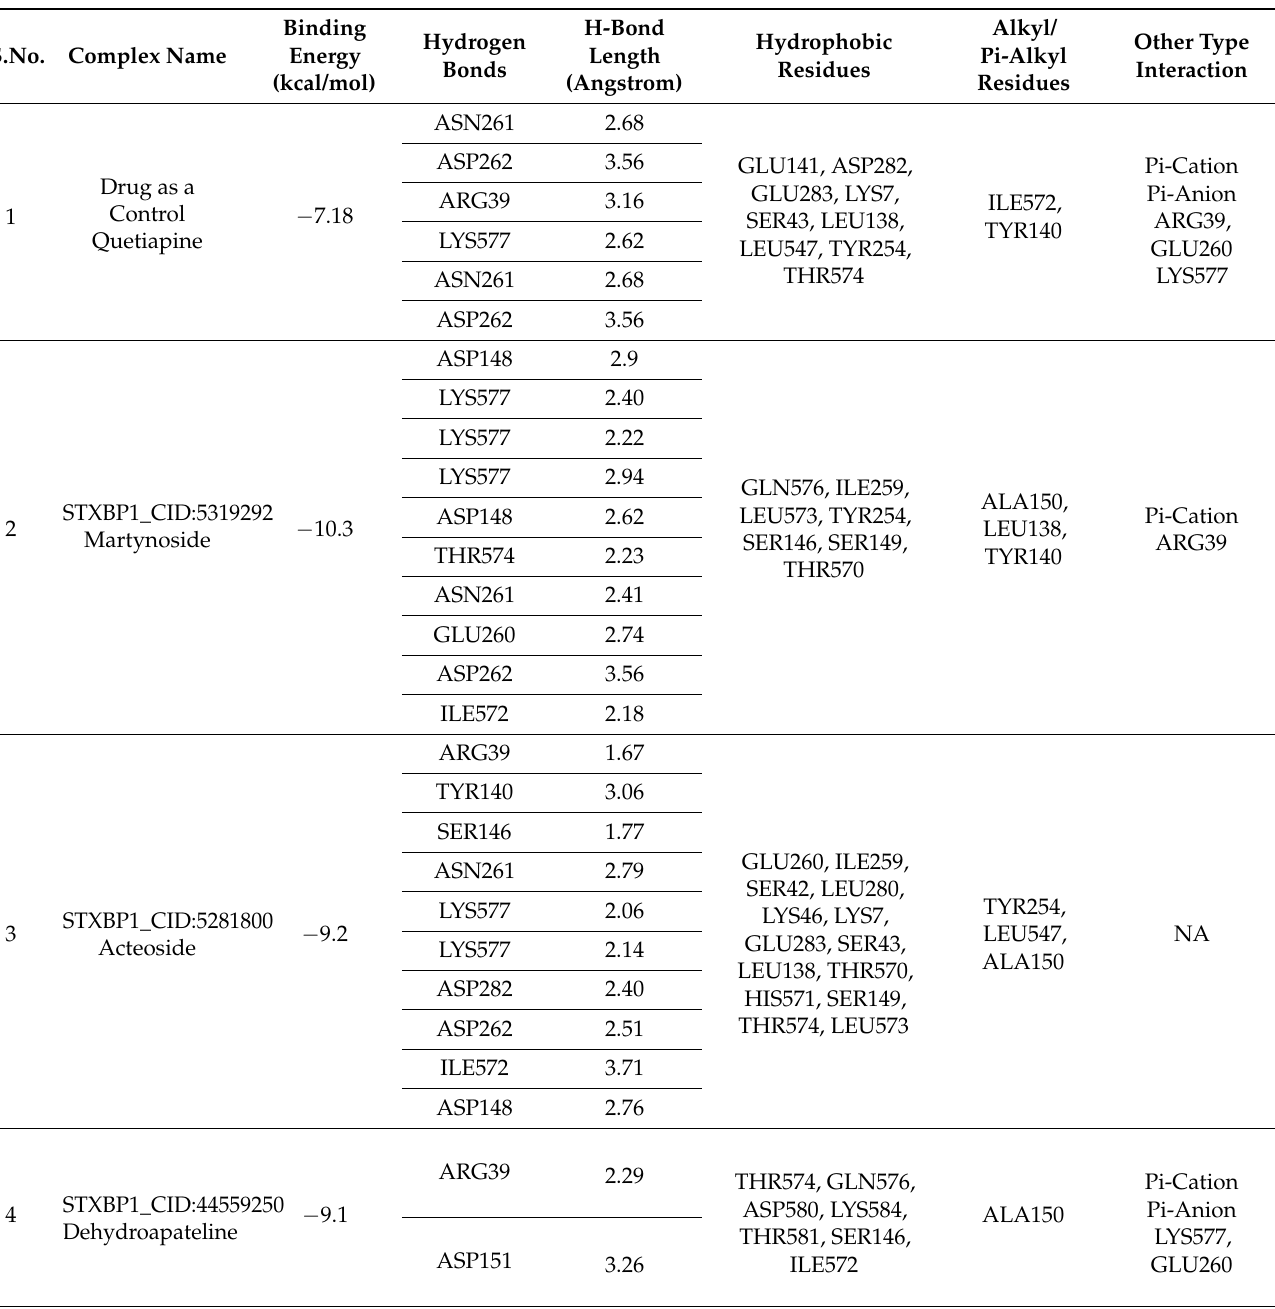
Table 2. Molecular docking data of top nine selected natural compounds of Bacopa interaction with